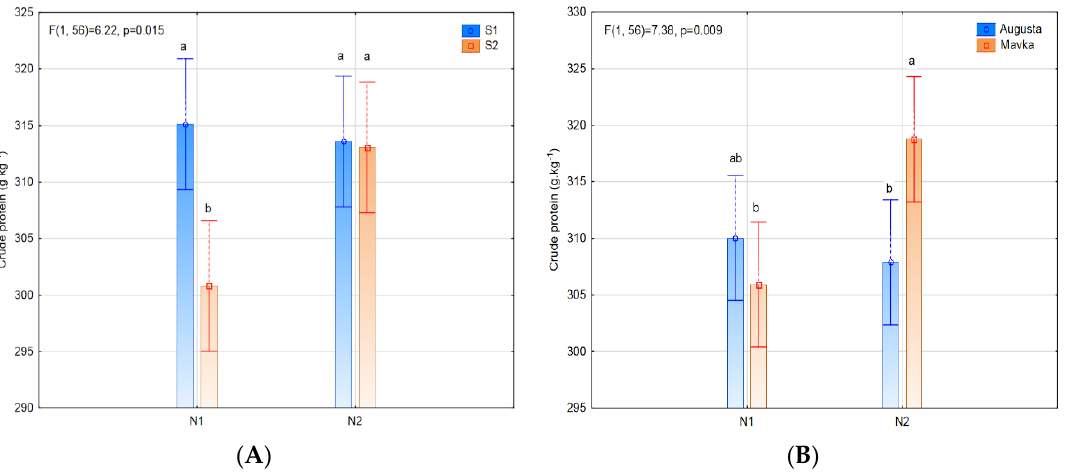
Figure 8. Significant interaction of sowing date and fertilization ( A ) and fertilization and cultivar ( B ) on crude protein content. The standard error (SD) of each mean is presented as a bar. The occurrence of the same letter pointer at averages (at least one) means that there is no statistically significant difference between them.